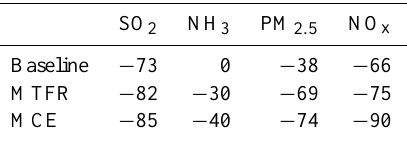
Table 1. Percentage change in emissions between 2008 and 2030 in the European Union.